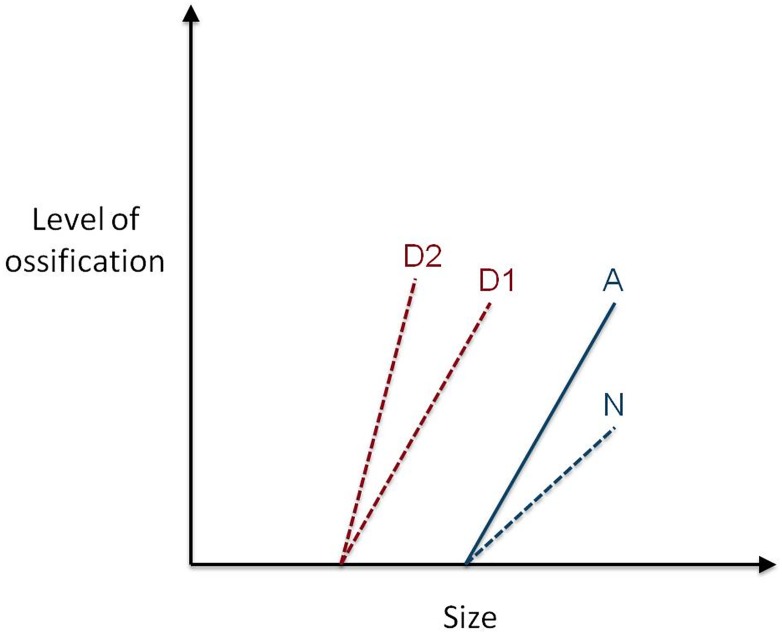
Heterochrony related to body size and level of skeletal ossification.Line leading to A represents ancestral condition. Line leading to N represents neoteny in the sense of a deceleration of rate of ossification, which produces a derived condition with a lesser degree of skeletal ossification. Line leading to D1 represents an earlier onset of ossification, producing a derived condition in which smaller body size is coupled with the same degree of ossification as ancestral condition. Line leading to D2 represents an acceleration in the rate of ossification combined with earlier onset, which produces a derived condition of smaller body size coupled with a higher degree of skeletal ossification.